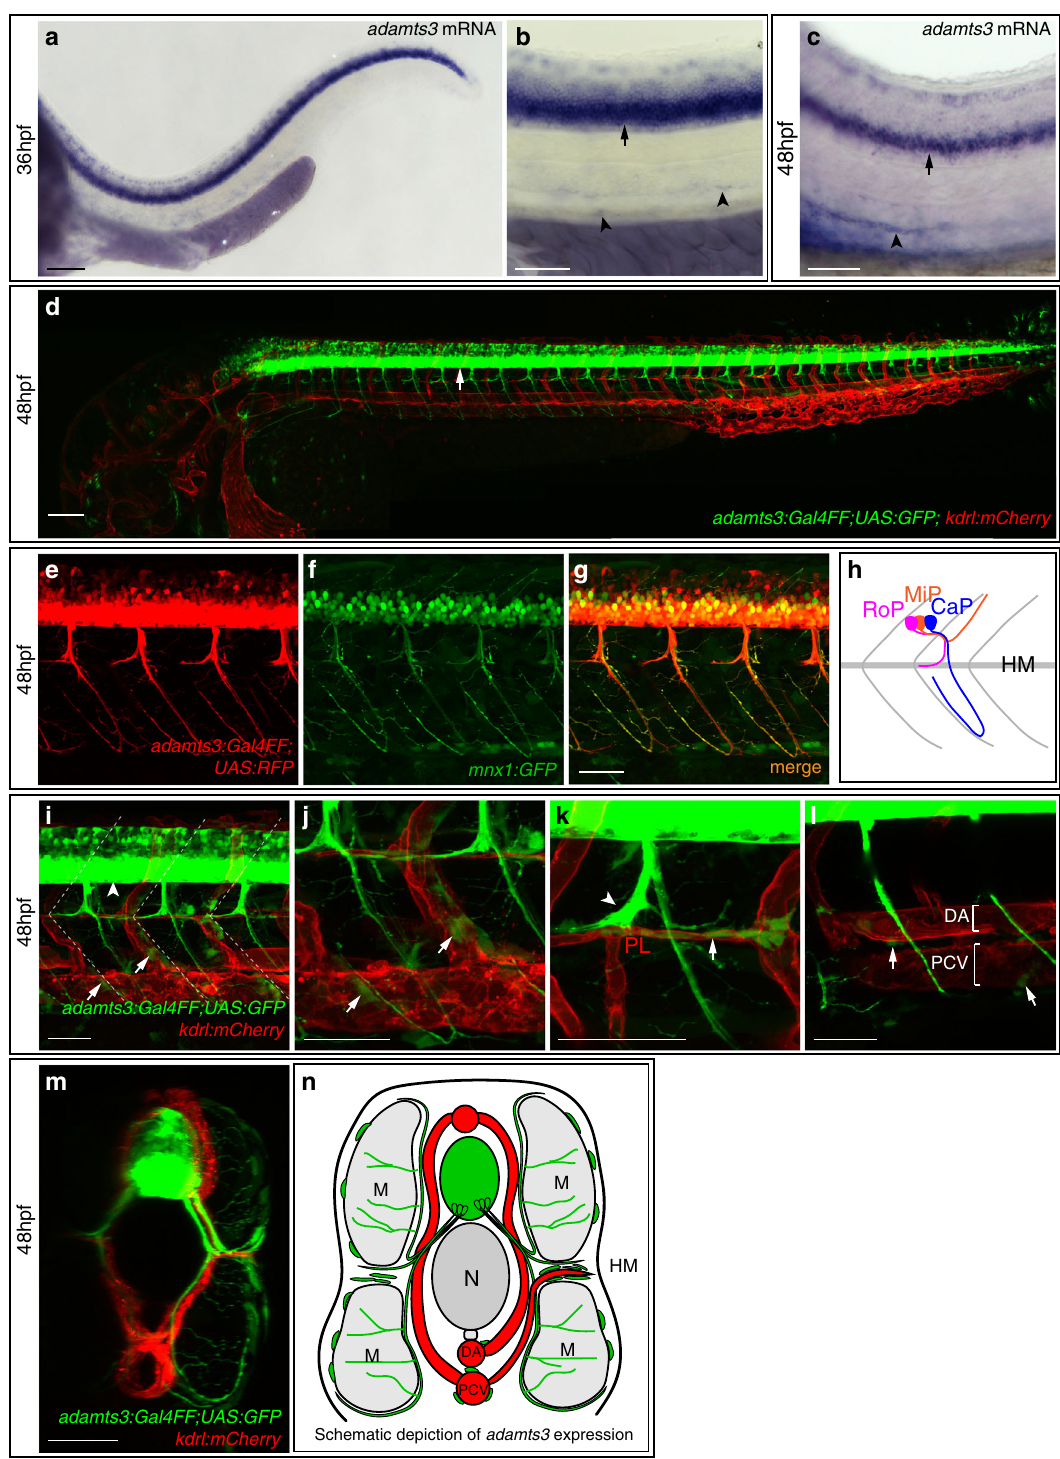
Schematic depiction of adamts3